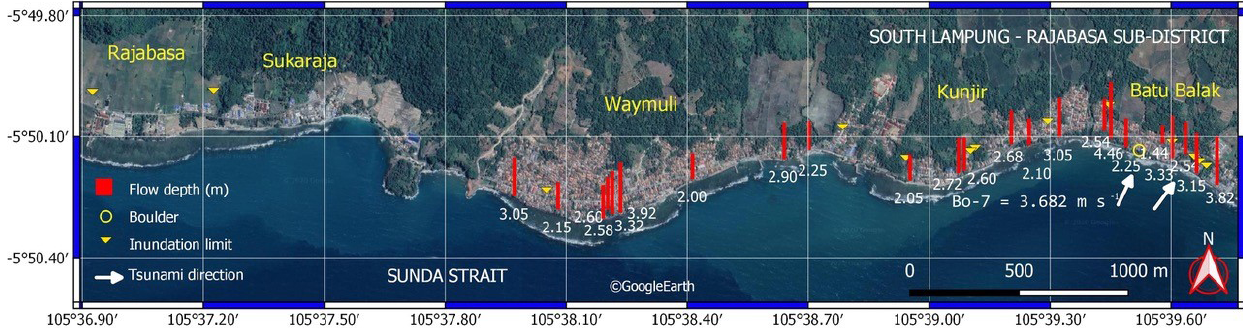
Figure 10. Flow depth distribution and run-up limits in Rajabasa, South Lampung. (The map was adapted from Google Earth.)